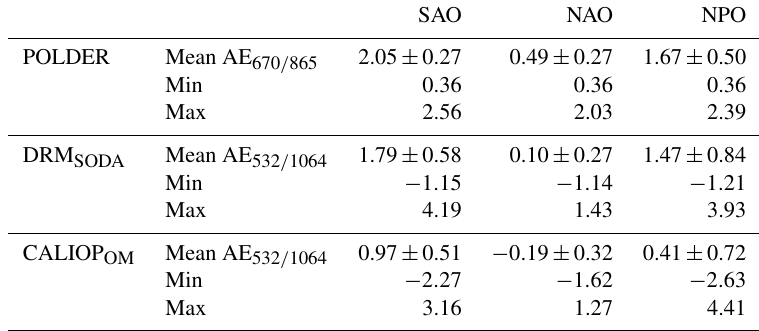
Table 5. Mean value of AE over 6 months in 2008 for three regions (SAO, NAO, NPO) for different methods after filtering the POLDER